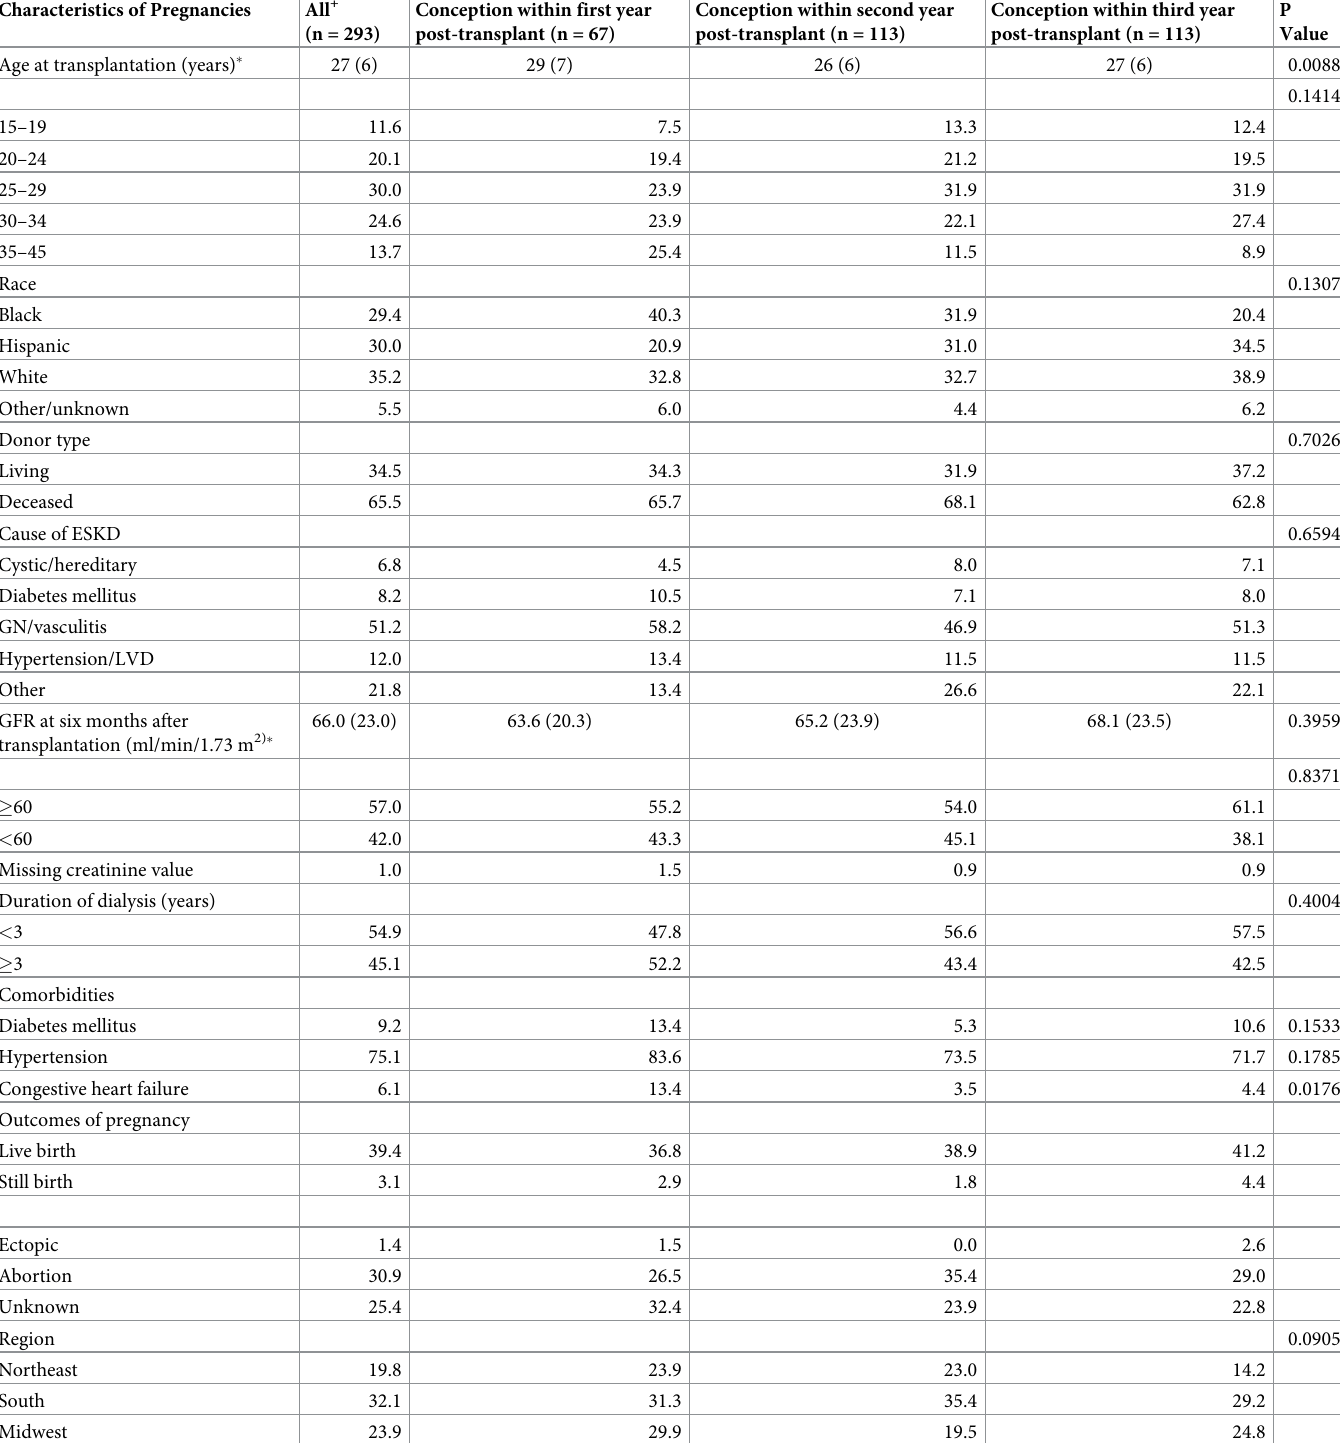
Table 2. Baseline characteristics of pregnancies among women of childbearing age separated by conception year post-transplant. Characteristics of